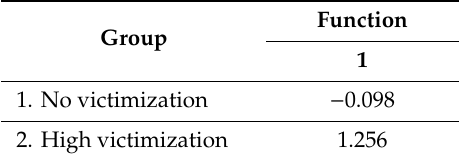
Table 2. Centroids of discriminant function for each group.